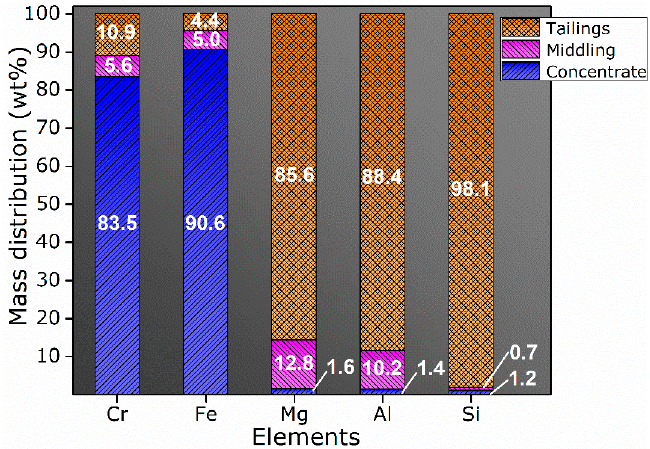
Figure 17. Elemental distribution (normalized to 100 wt % for each element) among the concentrate, middling, and tailings.